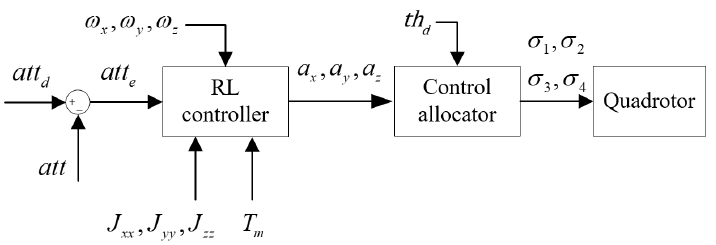
Figure 4. Control diagram for large-load plant-protection